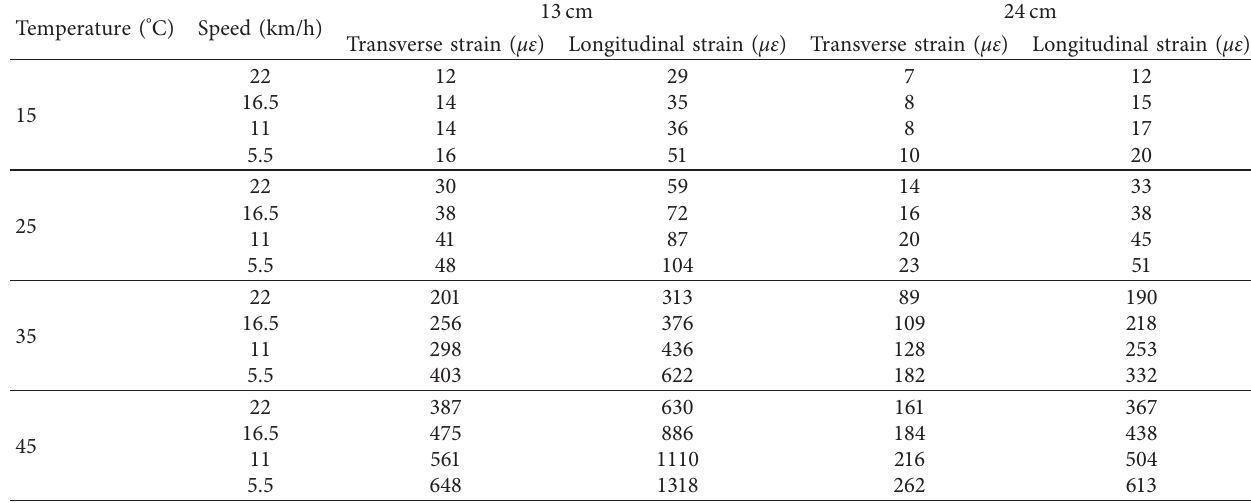
Table 4: Strain values of asphalt layer in the semirigid pavement at different conditions.